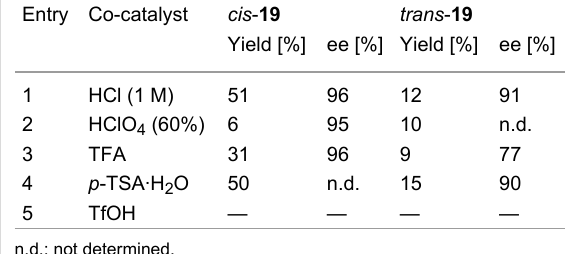
Table 4: Summary of the screening of co-catalysts.